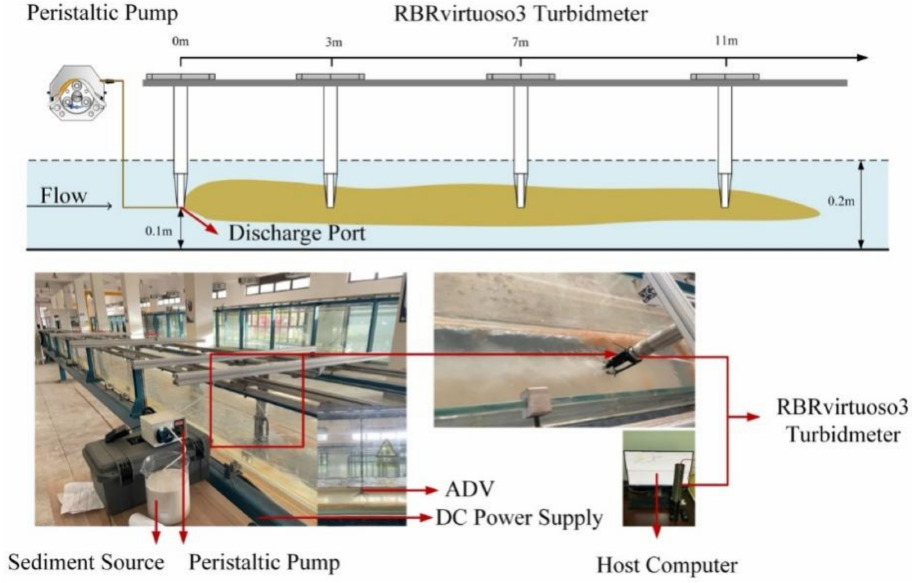
Figure 4. Set-up of the laboratory sediment-dispersion